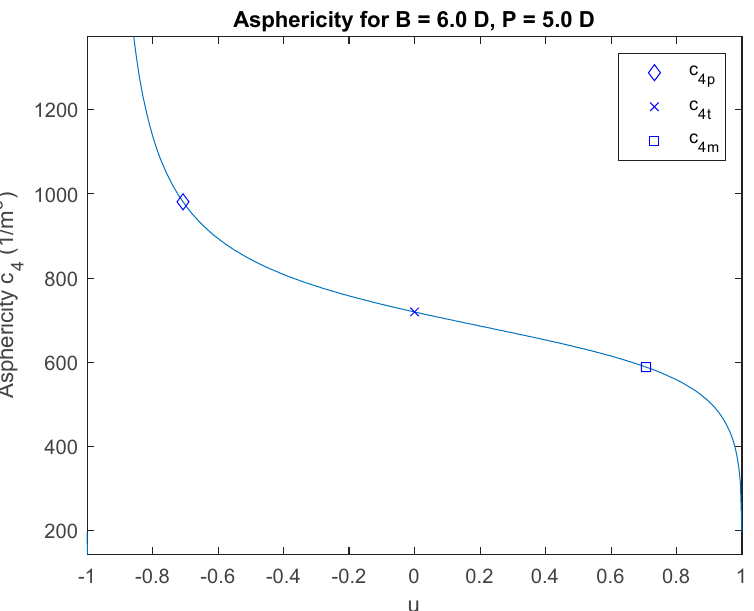
Figure 8. Fourth-order asphericity c 4 as a function of u for the same lens example used in Figures 5–7.